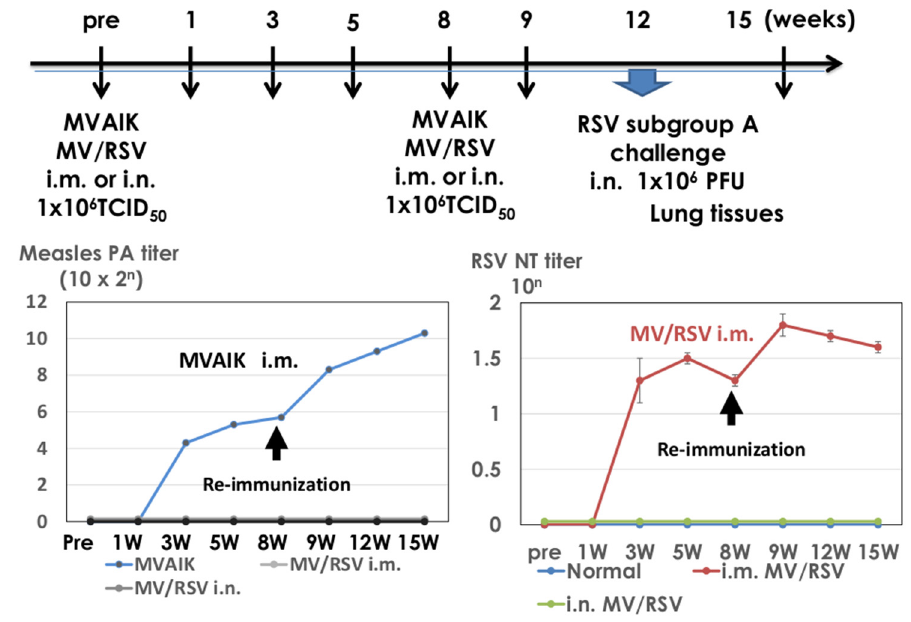
Figure 6. Immunization schedule and antibody responses against measles and RSV. Three cotton rats were immunized with MVAIK and MV/RSV through intra-nasal (i.n.) and intra-muscular (i.m.) routes and were reimmunized at 8 weeks after the first dose. They were challenged with 1 × 10 6 PFU of the RSV/Long strain 4 weeks after reimmunization. Lung tissues were obtained 4 days after the challenge. Measles PA antibody and RSV NT titers were examined. Immunization experiment was performed in duplicate.